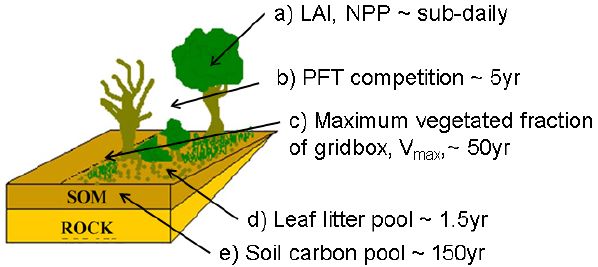
Fig. 1. Schematic of the main variables of the dynamic vegeta- tion and background albedo schemes, including the timescales of change. (a) The net primary productivity (NPP) and leaf area in- dex (LAI) are calculated at every time step; (b) the plant functional type (PFT) distribution is updated once per year, but depends on the average NPP of the last 5yr; (c) the maximum vegetated frac- tion, V max , is updated once per year, but depends on the NPP of the last 50yr; (d) the leaf litter pool has a turnover time of 1.5yr; and (e) the soil carbon pool has a turnover time of 150yr. The variables in (a) are calculated for all setups. (b) and (c) are calculated when the dynamic vegetation scheme is switched on; otherwise these are constant. (d) and (e) affect the albedo calculation when the back- ground albedo scheme is switched on. Adapted from Vamborg et al.